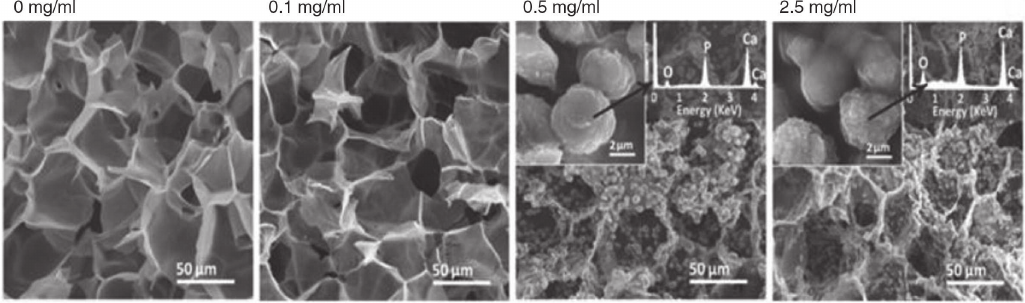
Figure 11: The SEM cross-sectional micrographs of hydrogel/HA nanocomposites containing different concentrations of HA nanoparticles after 30 days of incubation in SBF at 37°C. Reprinted from Ref. [28], Copyright (2015) with permission from